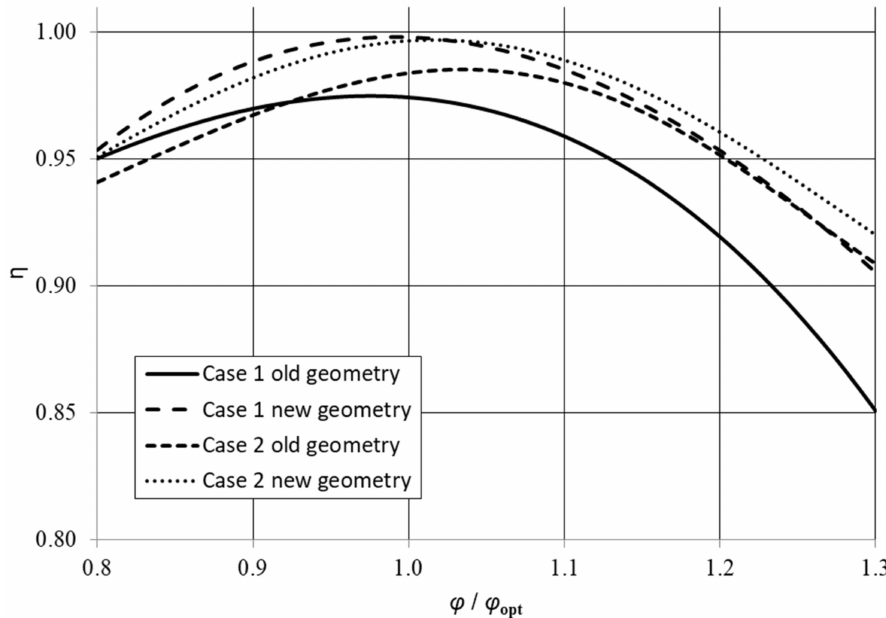
Figure 8. Hydraulic turbine efficiency of case 1 and 2 with and without SV modifications. Efficiency is relative to the maximal efficiency of the new geometry for each